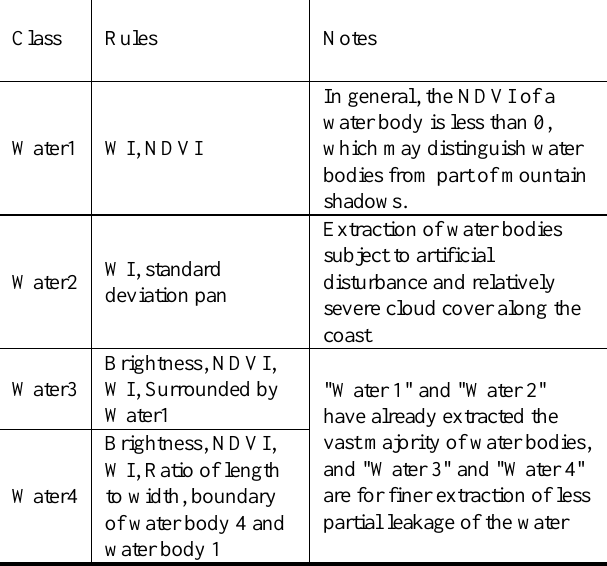
Table 2. Rules of Water Extraction